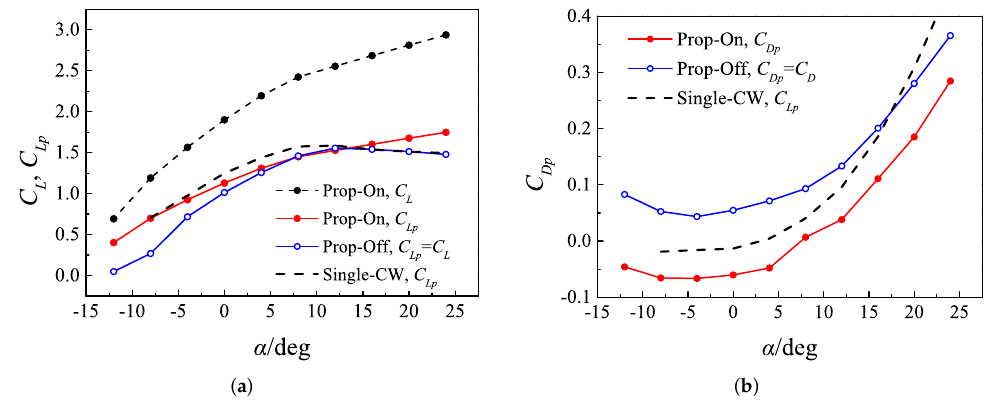
Figure 19. Performance of the channel wing at 20 m/s. ( a ) The lift coefficient; ( b ) The drag coefficient. The drag of the prop-on channel wing dropped sharply compared with the clean wing.